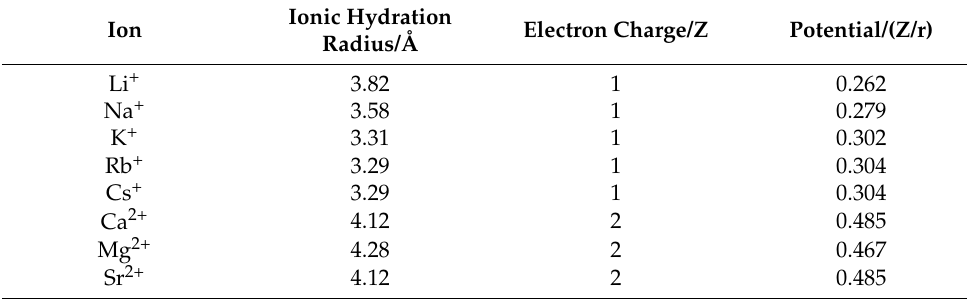
Table 1. The hydration radius and potential of the ions.